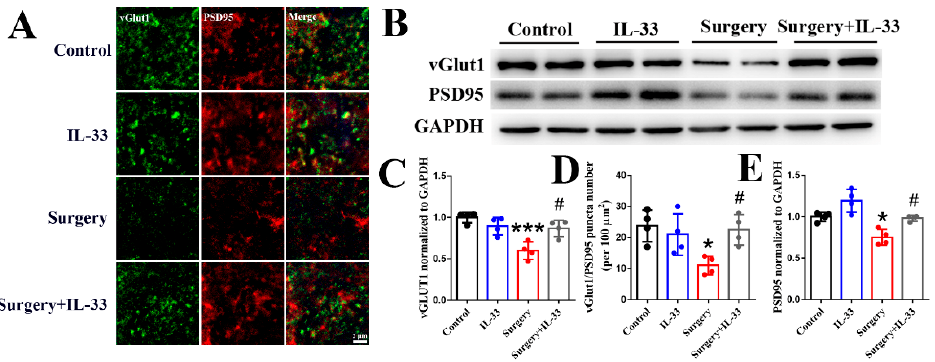
Figure 4. IL-33 upregulates the hippocampal number of excitatory synapses in dNCR aged mice. The levels of vGlut1 and PSD95 were detected by immunofluorescence ( A , C ) and Western blot ( B , D , E ), respectively, 3 days after surgery. Data are expressed as the mean ± SD (one-way ANOVA followed by Bonferroni’s post hoc test, n = 4 per group). * p < 0.05 and *** p < 0.001 versus the control group; # p < 0.05 versus the surgery group.